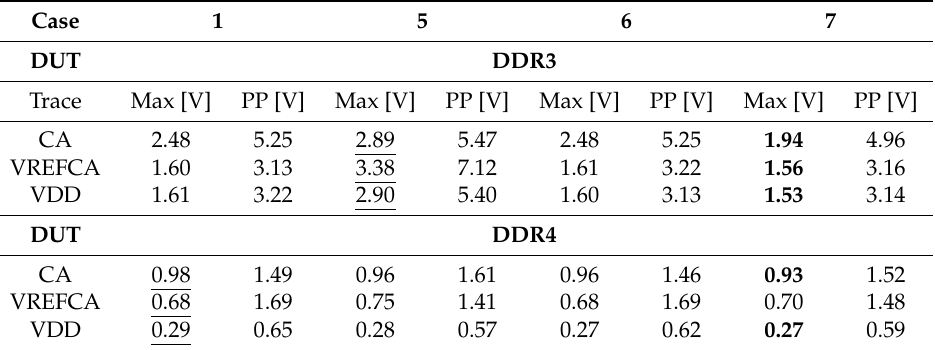
Table 10. Comparison of coupled ESD noise voltages for various DOE cases in Figure 19 (waveform results in Figure 19) (bold: minimum value; underline: maximum